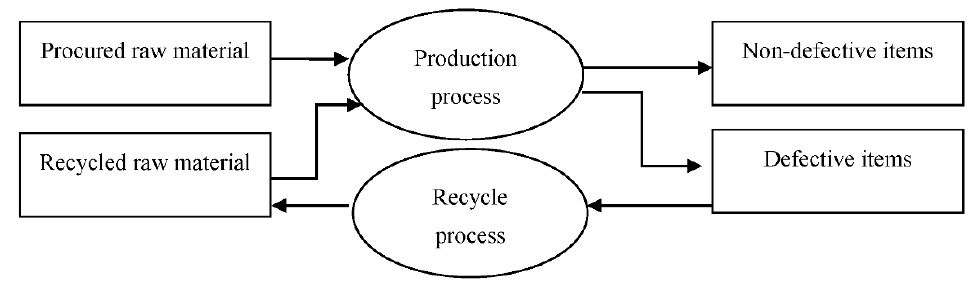
Figure 3. Framework of recycling.